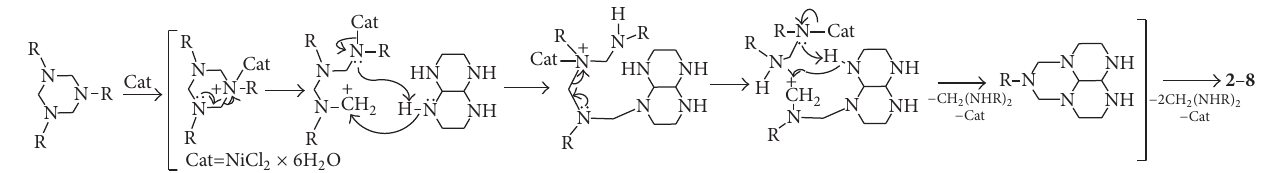
Scheme 2: The possible reaction